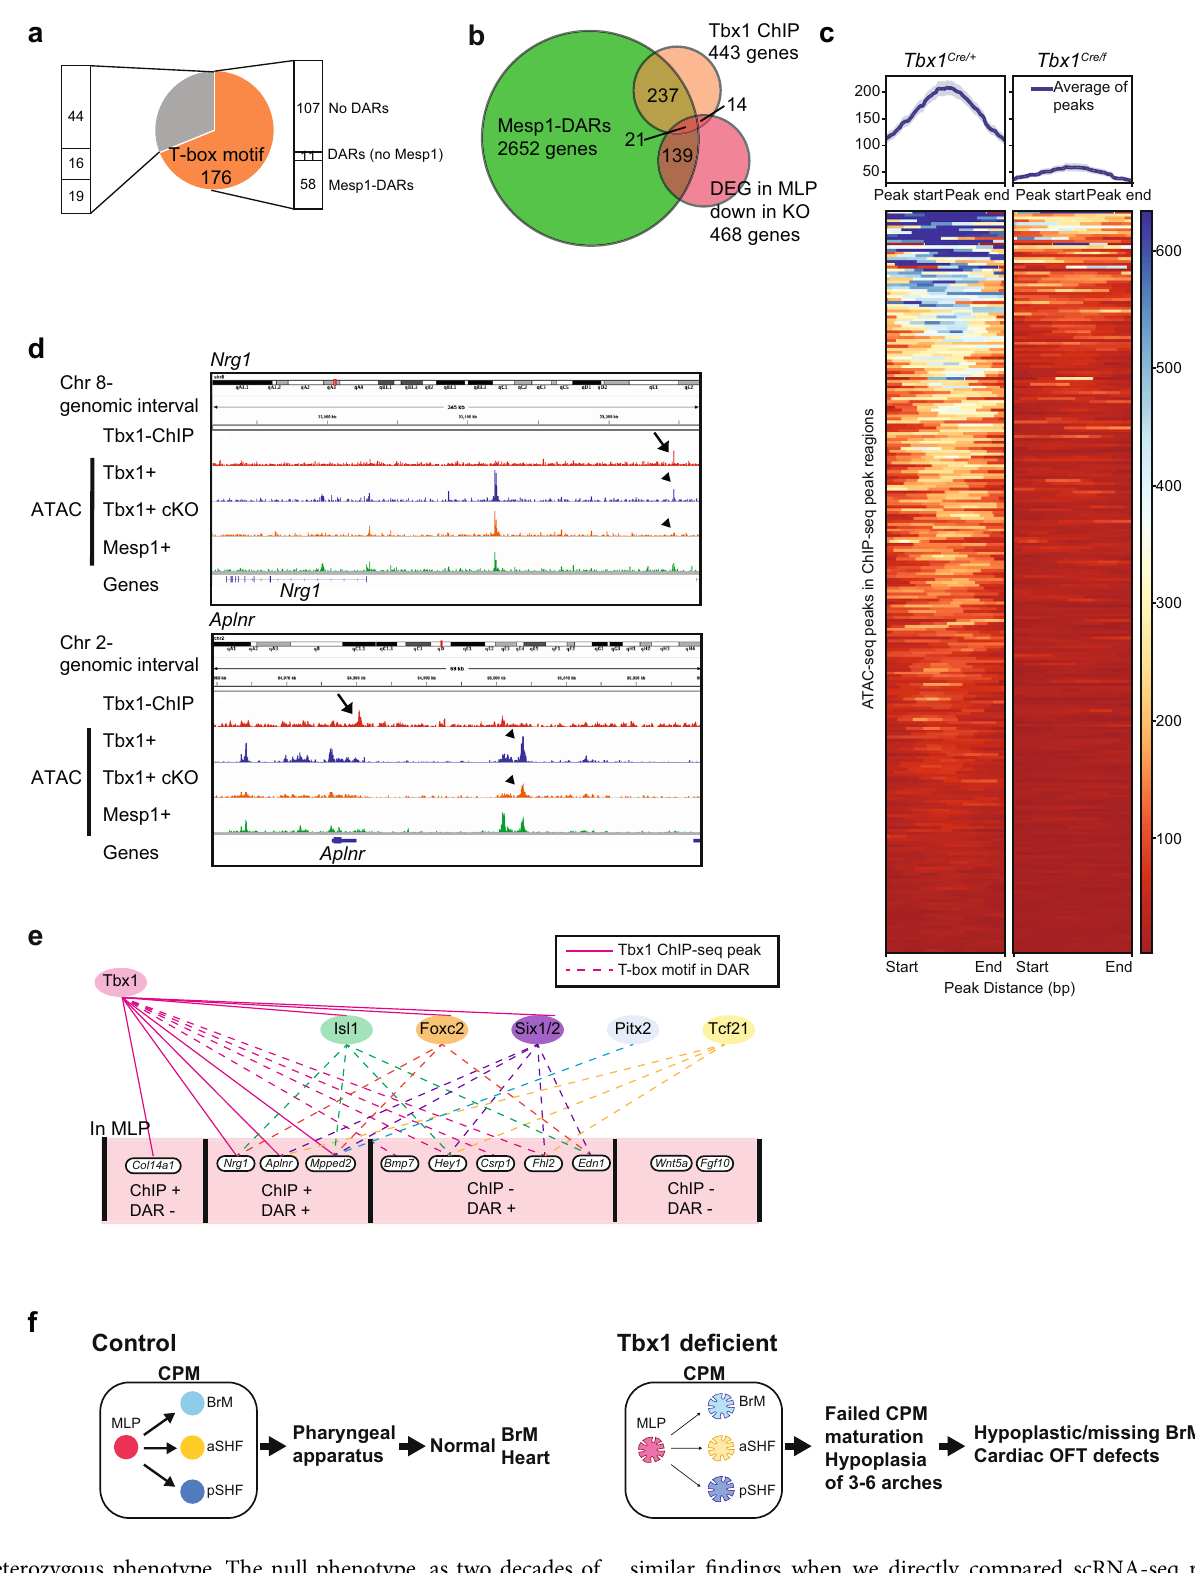
heterozygous phenotype. The null phenotype, as two decades of publications indicate, is remarkably similar across multiple genetic backgrounds. Therefore, the genetic background- dependence of the heterozygous phenotype would not affect the major conclusions of the manuscript.